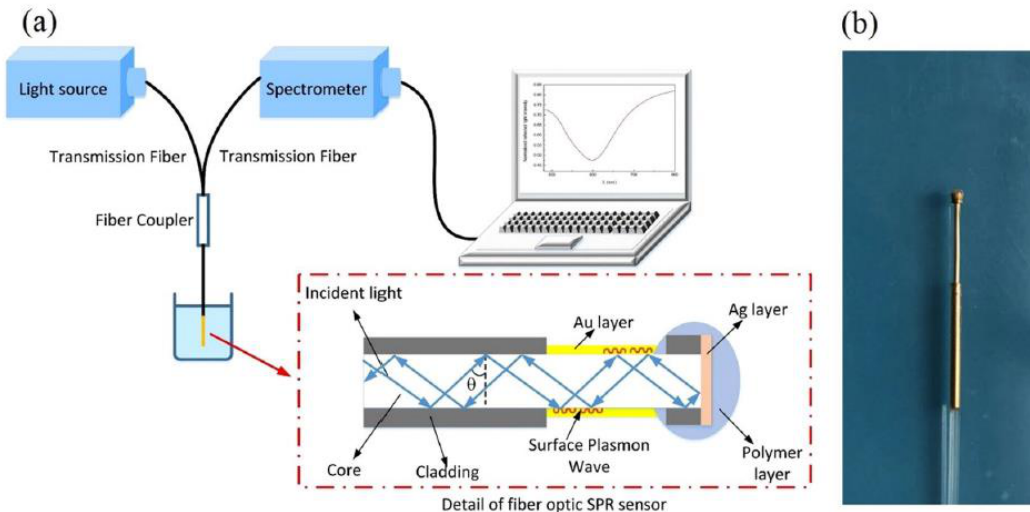
Figure 4. Plasmonic fiber optic sensing system in [28], ( a ) schematic of the experimental setup including light source, transmission fibers, plasmonic fiber-optic sensor, and spectrometer and ( b ) the